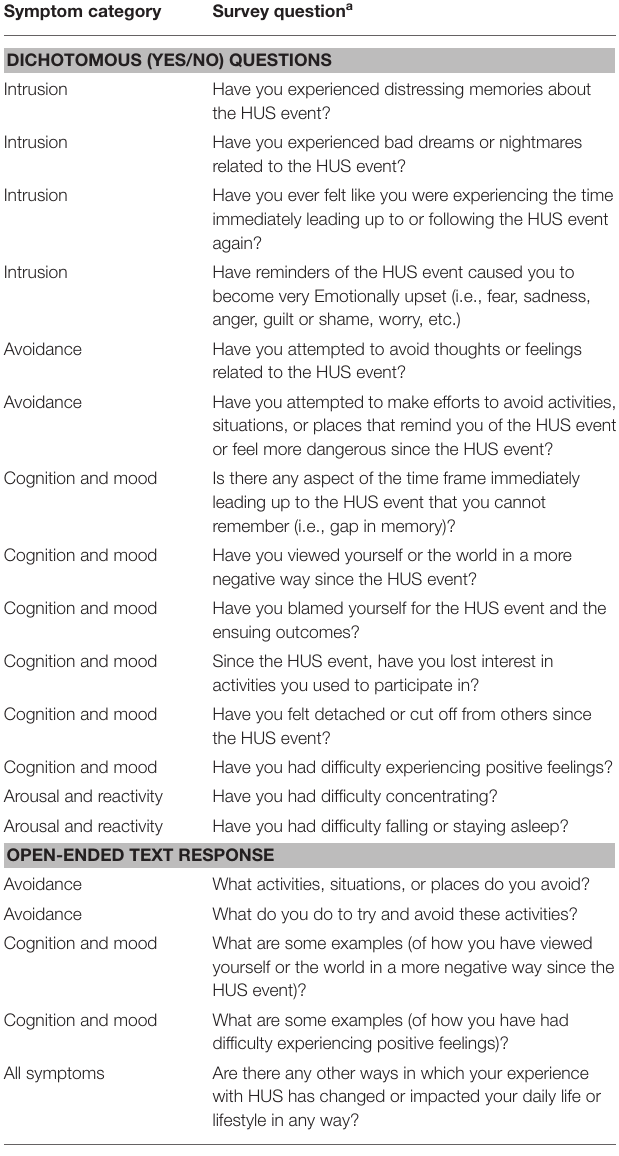
TABLE 1 | Posttraumatic stress symptoms evaluated among survey